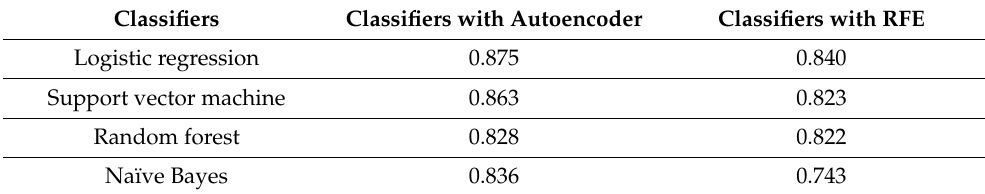
Table 5. Classifier with dimensionality reduction and feature selection technique.